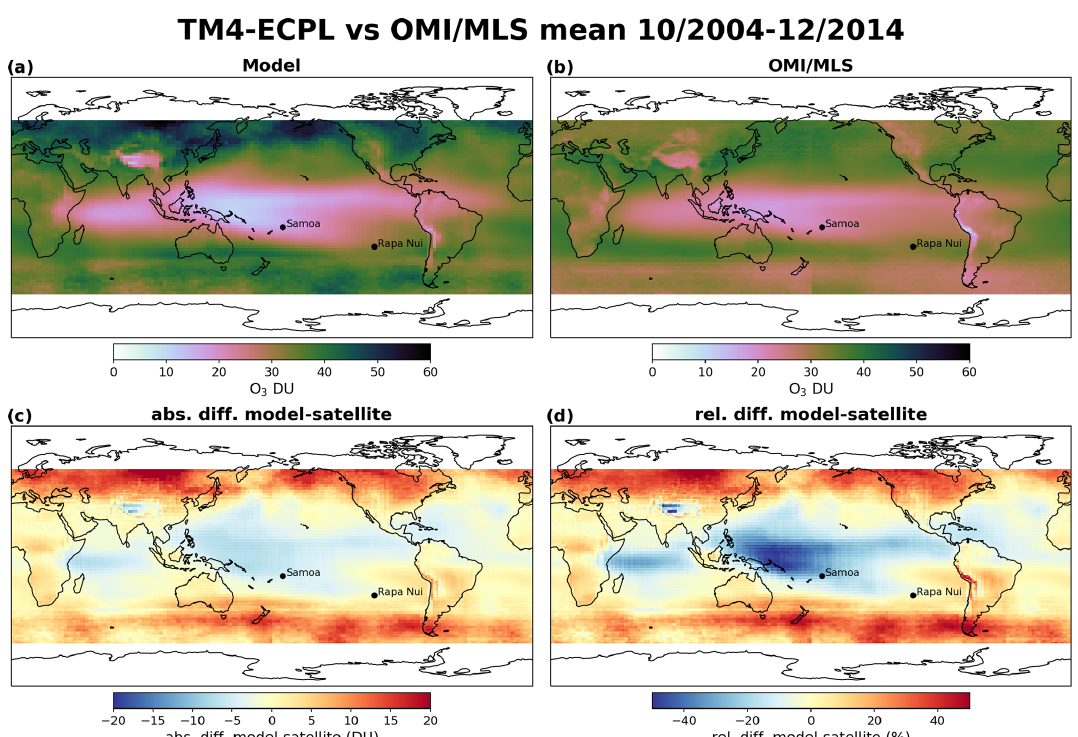
Figure 3. Model–satellite comparison between TM4-ECPL and OMI/MLS mean tropospheric ozone column between October 2004 and December 2014. Panel (a) shows the average modeled tropospheric ozone column for the period, panel (b) the average observed tropospheric ozone column, panel (c) the absolute difference between model and satellite (DU), and panel (d) the relative difference (%) between model and satellite in the 1 ◦ × 1 . 25 ◦ grid of the OMI. The black dots show the location of Samoa (left) and Rapa Nui (right).